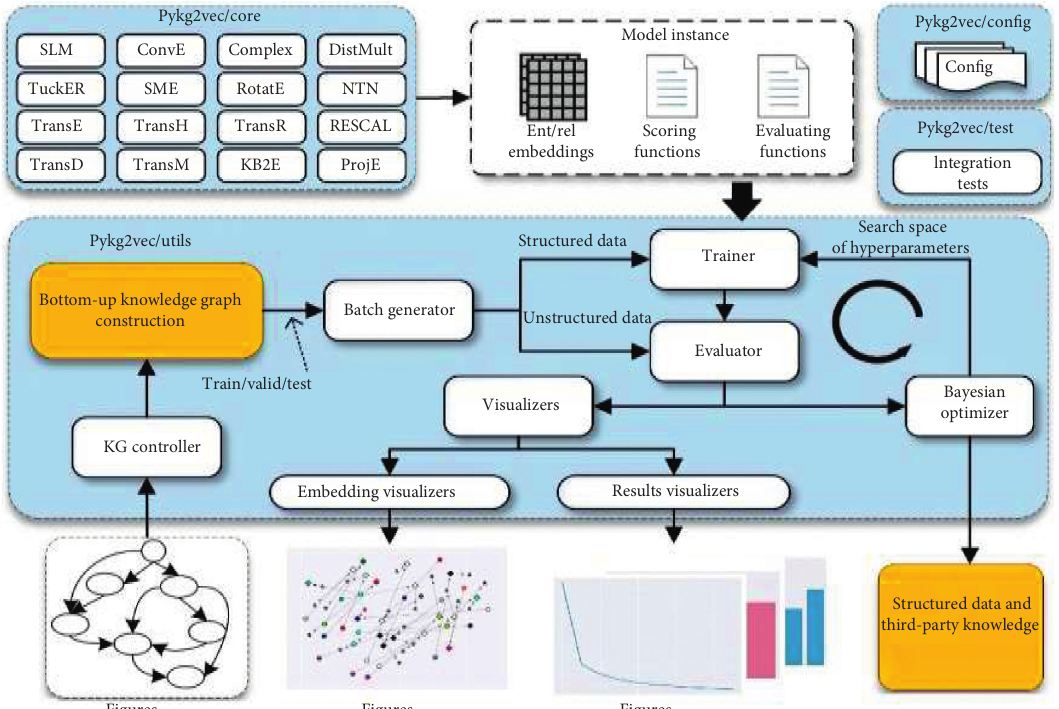
Figure 1: Bottom-up knowledge graph